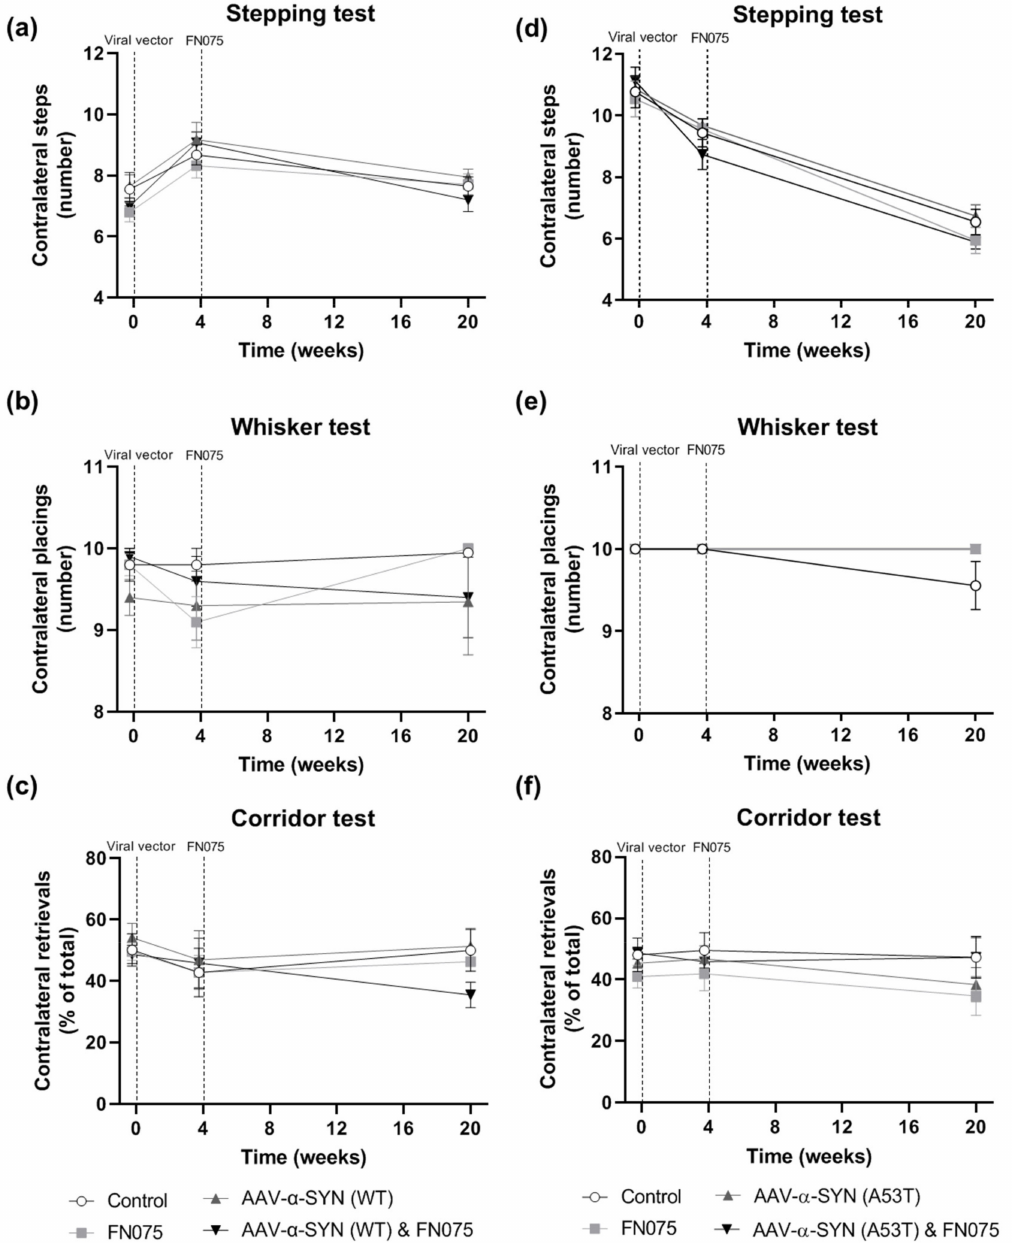
Figure 8. Impact of AAV- α -synuclein vectors alone or in combination with FN075 on contralateral motor function. ( a – c ) AAV- α -SYN (WT) or ( d – f ) AAV- α -SYN (A53T), alone or in combination with FN075, did not induce contralateral motor dysfunction in the Stepping, Whisker or Corridor behavioral tests. Data are represented as mean ± SEM with n = 8–10 animals per group by two-way repeated-measures ANOVA. Dashed lines represent the days of infusion